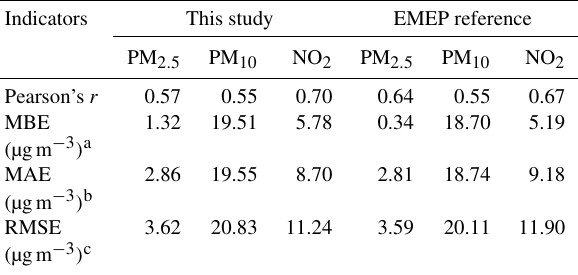
Table 1. Model quality indicators for estimations from the present study and for the reference results reported by the